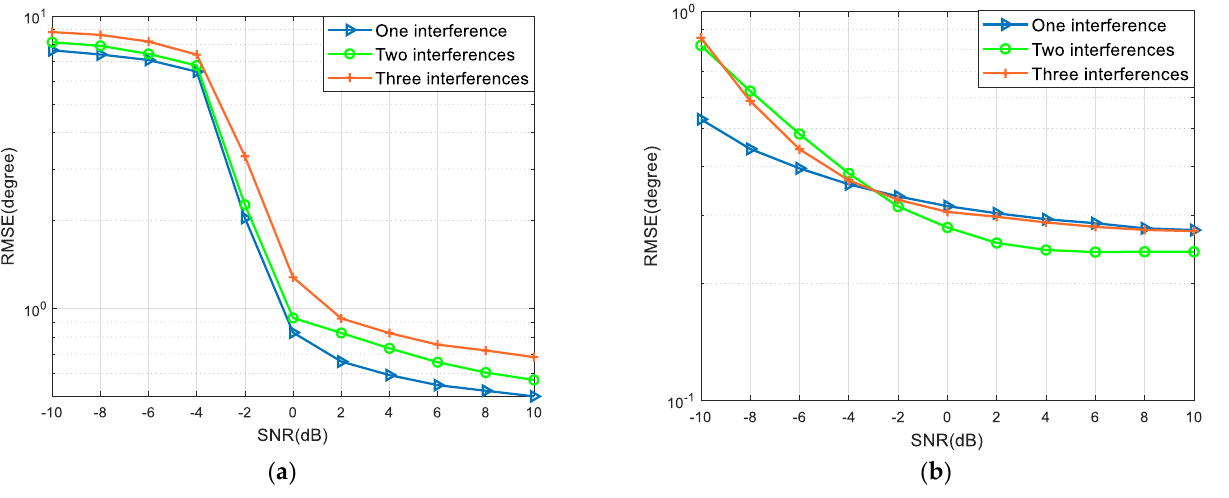
Figure 4. Variation curve of algorithm performance with SNR under different numbers of interference sources: ( a ) To-JJM algorithm; ( b ) FPB-To algorithm.